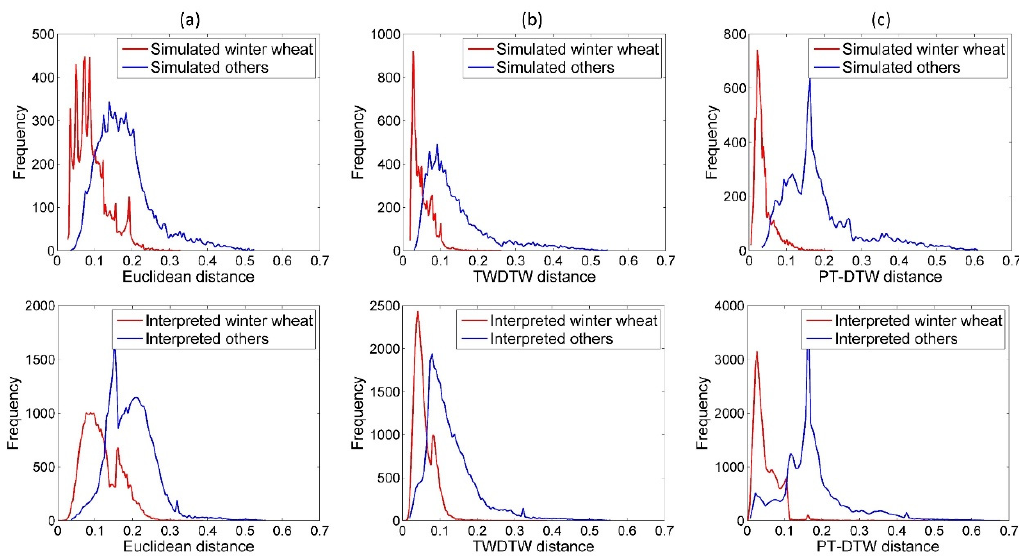
Figure 14. ( a ) Euclidean distance, ( b ) TWDTW distance, and ( c ) PT-DTW distance of simulated and visually interpreted winter wheat and other samples. Table 3. Comparison of Euclidean distance-based methods through simulated and field samples. Simulated